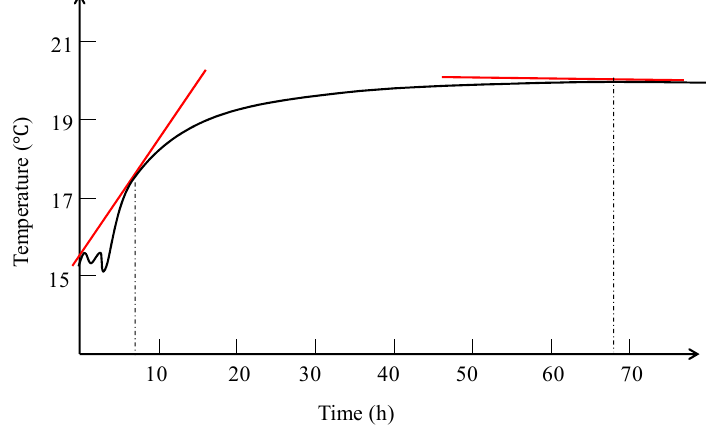
Figure 11. The determination of the temperature rising duration.